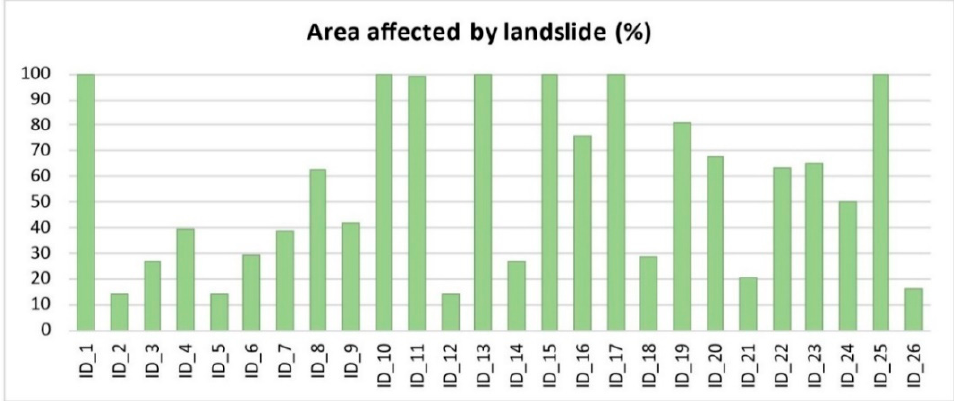
Figure 5. Surface affected by mapped landslides (in percentage respect to the total area of the AOI). Data from IFFI Inventory map [40].